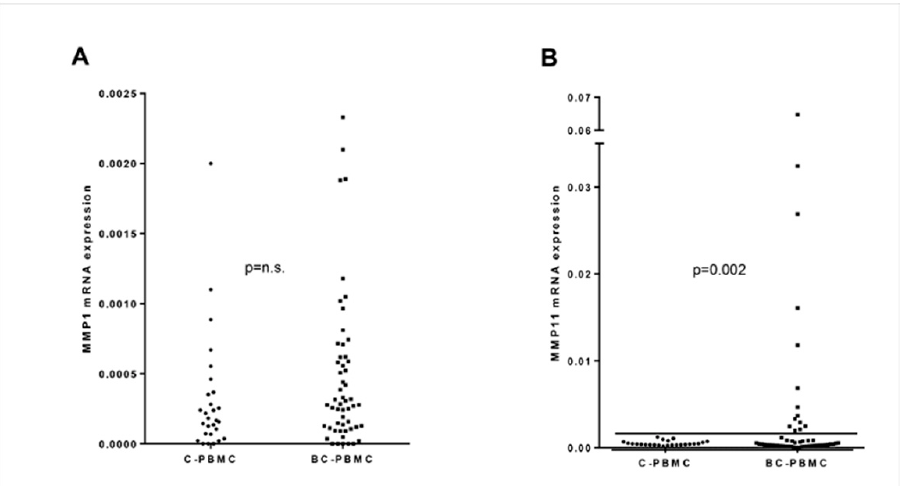
Figure 1. MMP1 and MMP11 gene expression in peripheral blood mononuclear cells (PBMC) from breast cancer patients. MMP1 ( A ) and MMP11 ( B ) gene expression in PBMC from breast cancer patients (BC-PBMC, n = 54) and healthy women (controls, C-PBMC, n = 28). The horizontal line marks an arbitrary threshold, corresponding to the highest MMP11 gene expression in C-PBMC, used as cut-off point. Significant difference was found between MMP11 gene expression in BC- PBMC from patients above the threshold and C-PBMC. (n.s.: not significant). Results of the qRT- PCR data were represented as ΔΔ CT values.